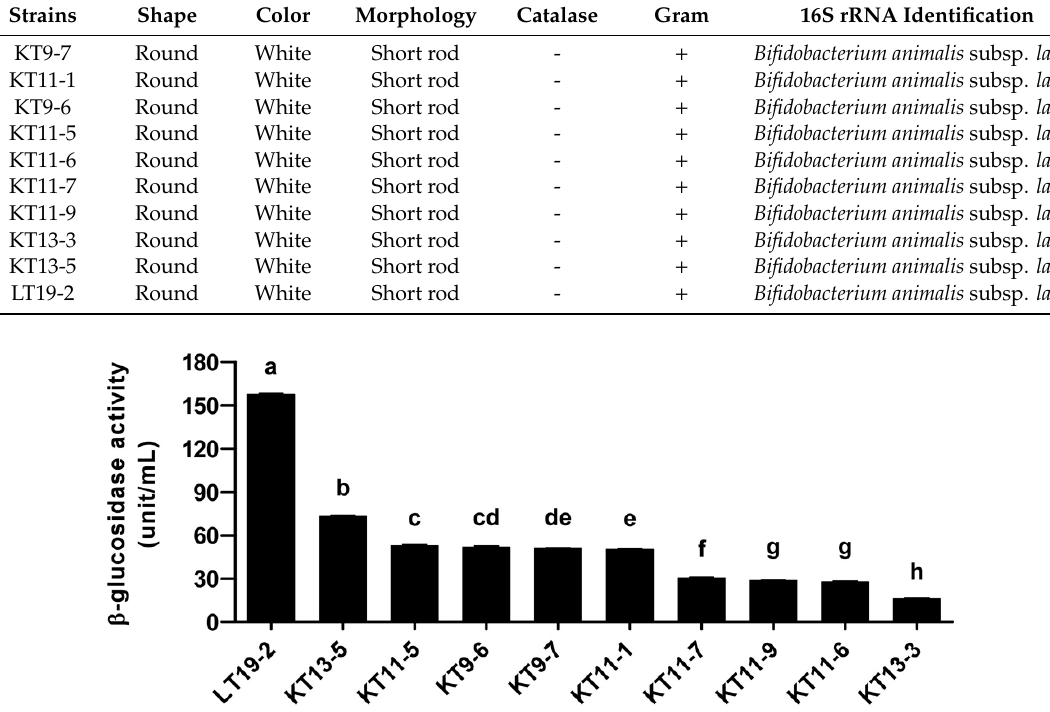
Table 2. Identification of selected strains isolated from infant feces.